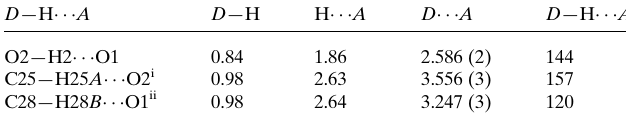
Table 1 Hydrogen-bond geometry (A˚ , (cid:3) ).